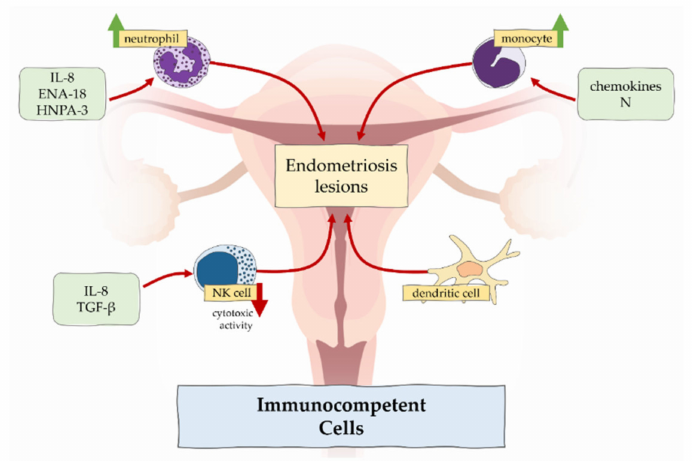
Figure 1. The role of immunocompetent cells in